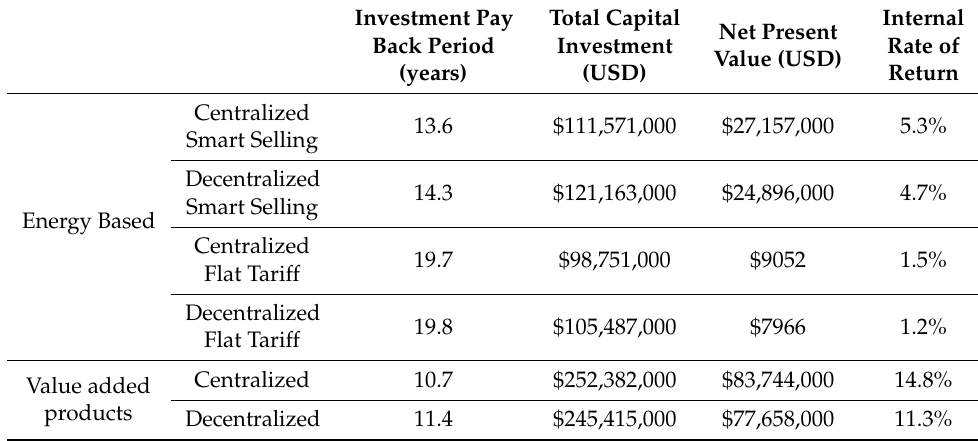
Table 7. Economic analyses of the bioenergy unit scenarios.